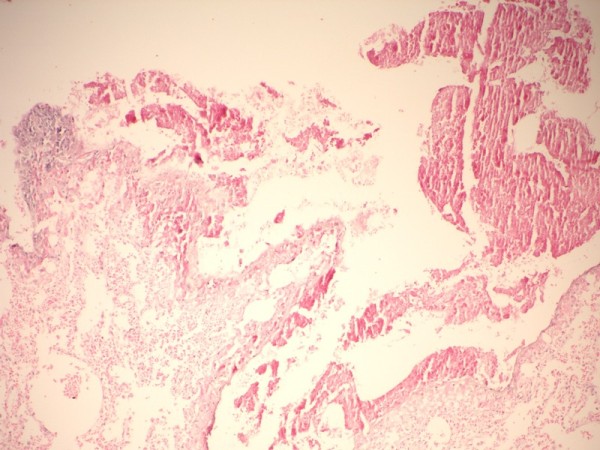
Changes in the early period (intraoperative) in the lung in which Ankaferd was applied. Hemolyzed clot masses (blood-fibrin masses) are observed in the areas exposed to Ankaferd ( H&E, X200)